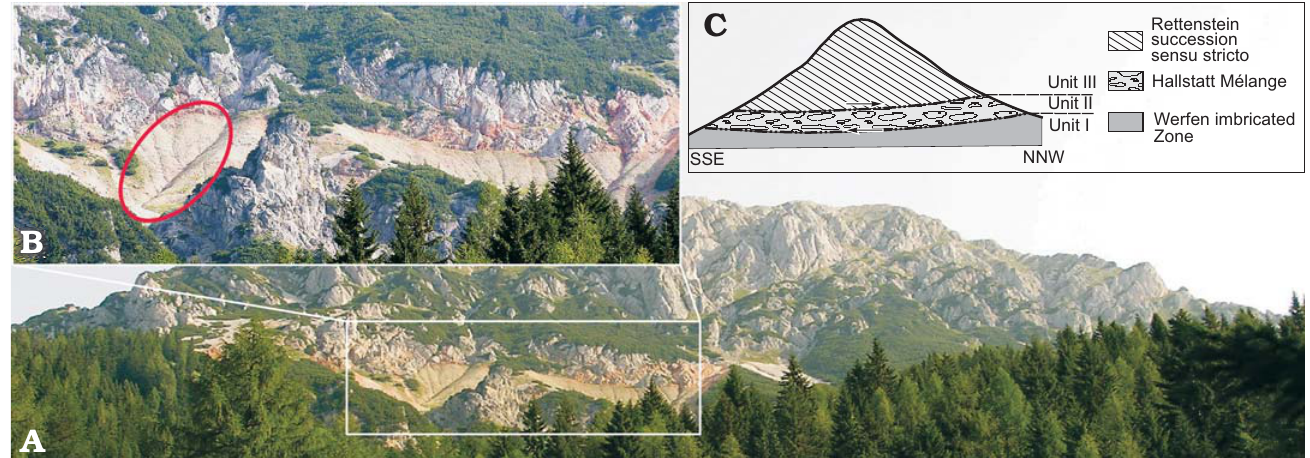
Fig. 3. A . View of the complete Mount Rettenstein complex from the southwest. B . Position of the studied section in the Weitenhaus cirque, the oval indicates the location where the studied samples were collected. C . Schematic sketch of the structural build of Mount Rettenstein with the three main tectonic units (from Auer et al. 2006). Structural Unit I: The primary part of the Tirolic mega-unit which, in contrast to the higher structural units, stayed (more or less) in place relative to the basis of the Upper Tirolic thrust sheet. In the Mount Rettenstein region, Permian to early Middle Triassic strata make up the succession above the Greywacke Zone basement (Ganss et al. 1954). Structural Unit II: This intermediate, rather thin sheet is mainly made up of a laterally variable mega-slide succession of the Middle Jurassic Hallstatt Mélange. It is thought to have achieved its present position in the hangingwall of a normal fault (Auer et al. 2006). Structural Unit III: The topmost Mount Rettenstein unit corresponds to the Lower to Upper Jurassic Mount Rettenstein succession sensu stricto in the sense of Auer et al. (2009). It is suggested to have been emplaced along a thrust fault (Auer et al.